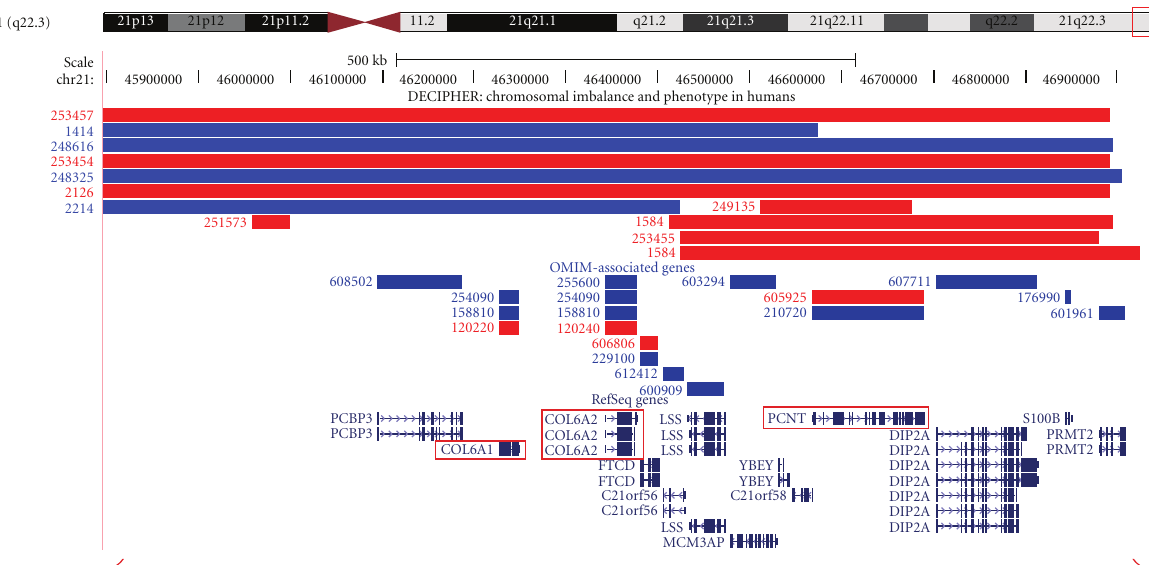
Figure 2: Location and extent of the loss of genomic DNA on the ring chromosome 21. An ideogram of chromosome 21 and the genes that are located within the deleted region of the ring chromosome 21 are shown. Entries in the DECIPHER database (deletions are shown in red, and duplications are shown in blue), OMIM genes, and RefSeq genes are taken from the UCSC genome browser http://genome.ucsc.edu/ (Human Mar. 2006 (NCBI36/hg18) assembly). The deletion cases in DECIPHER have proximal breakpoints at positions 40.16 Mb (case 253457), 43.99 Mb (case 253454), and 45.35 Mb (case 2126), and that reported by Bertini et al. [4] (not shown above) starts at 43.50 Mb; all four deletions end at 46.89 Mb. The COL6A1 , COL6A2, and PCNT genes are shown in red boxes. The horizontal red line with arrow heads denotes the extent of the chromosome 21 loss detected in the case reported